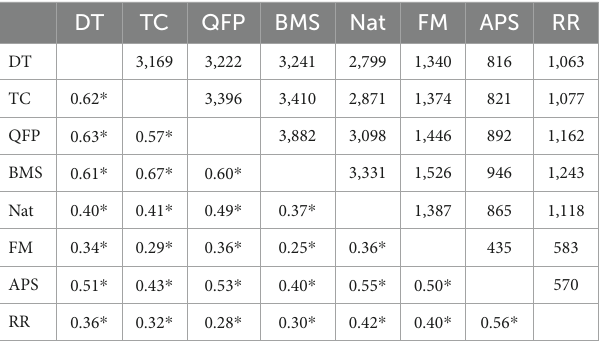
TABLE 3 Correlations between the sum scores of all subtests.